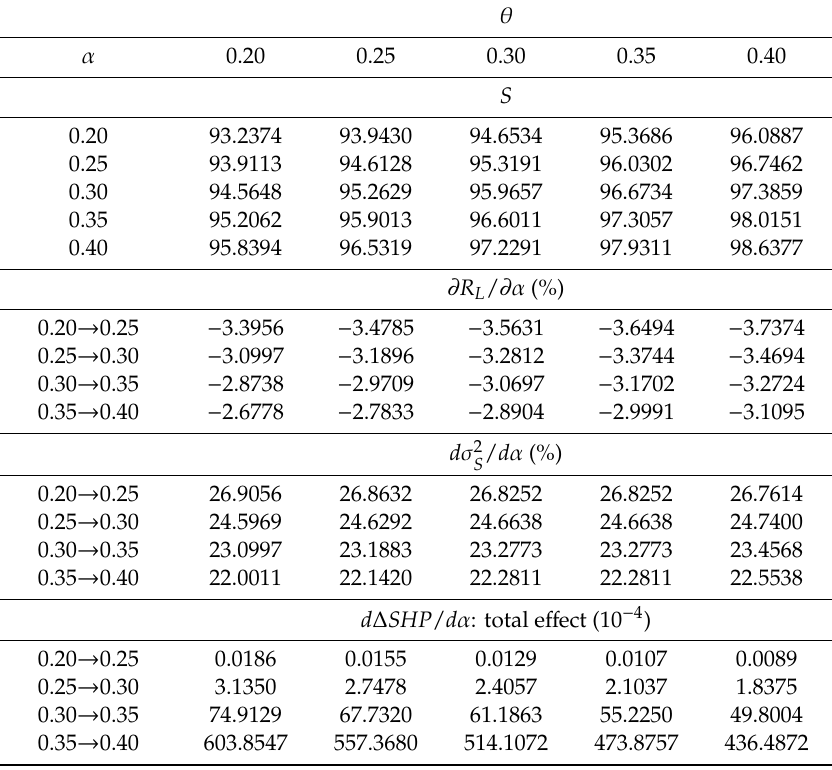
Table 3. E ff ects of international loan portfolio diversification degree on diversification e ffi ciency at various levels of government capital injection.